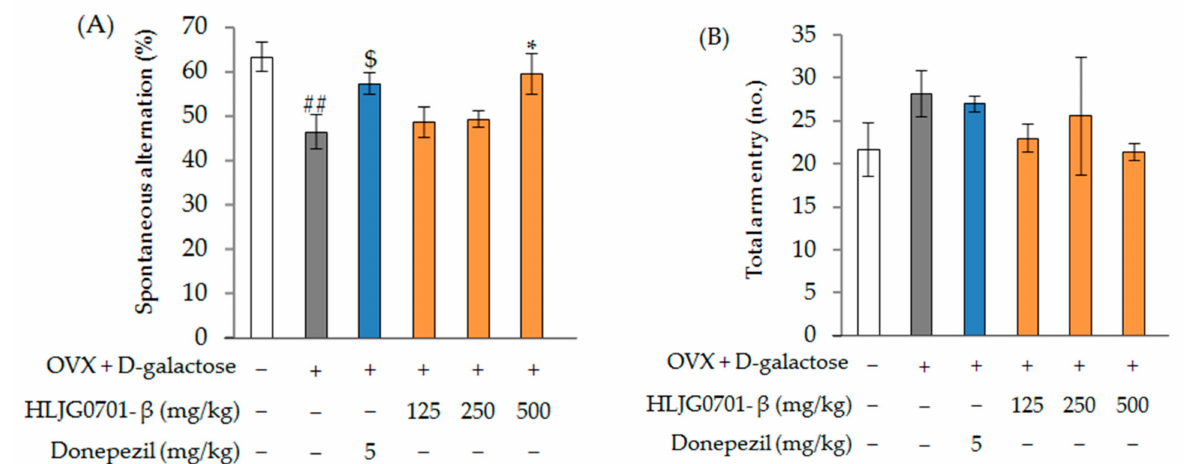
Figure 8. The Y-maze task in OVX + D -galactose-induced female mice. ( A ) Spontaneous alternation; ( B ) total arm entry. Data are presented as mean ± standard deviation. Error bar: standard deviation. ##, significant difference compared with control by Student’s t -test, p < 0.01; $, significant difference compared with OVX + D -galactose group by Student’s t -test, p < 0.05; *, significant difference compared with OVX + D -galactose group by one-way ANOVA, p < 0.05.